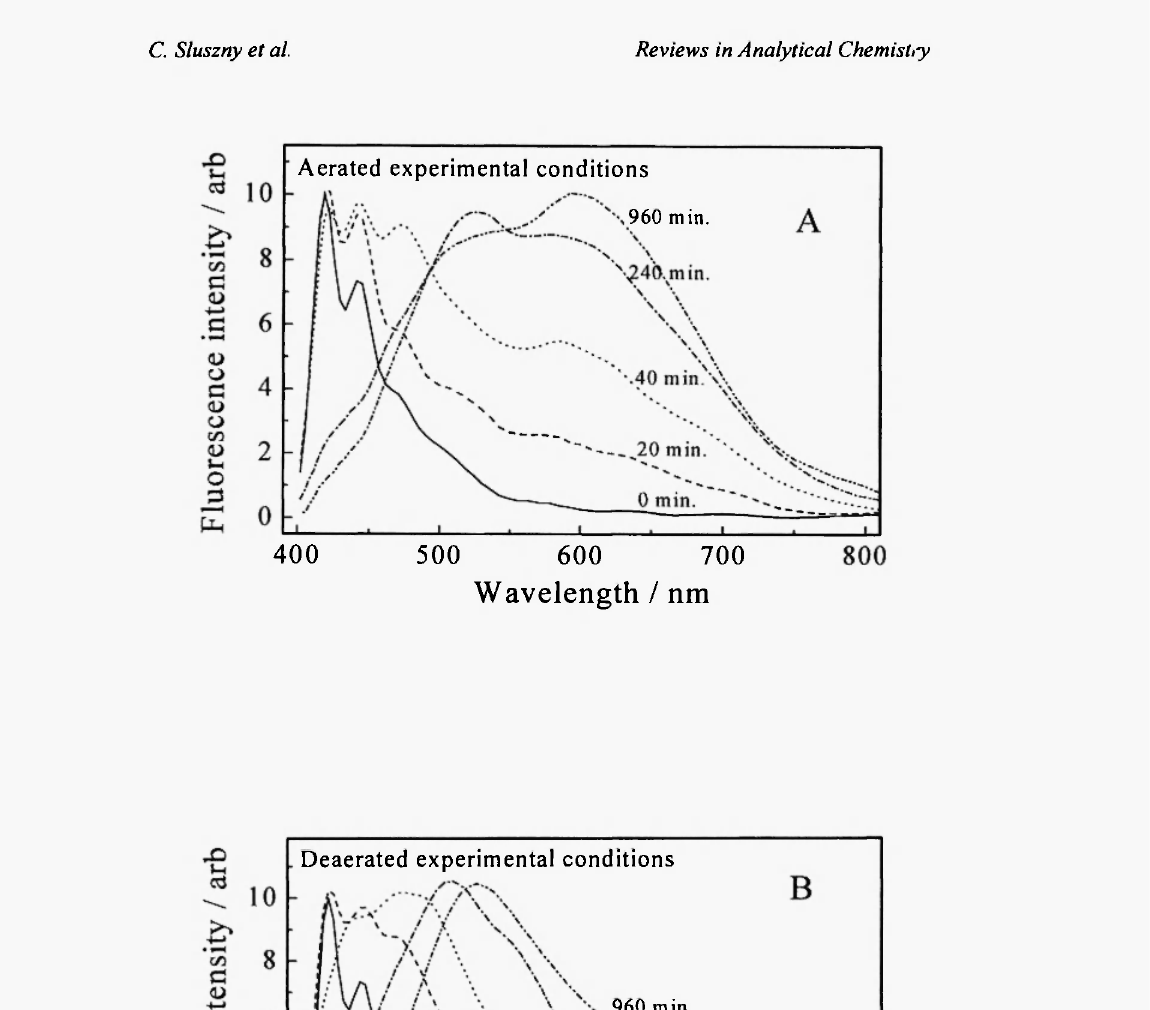
Fig. 28: Fluorescence spectra obtained from irradiated anthracene crystallites under: A) aerated and B) deaerated experimental